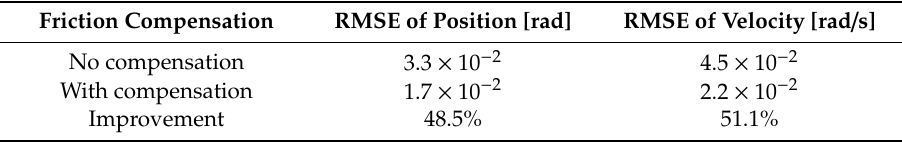
Table 2. Position and velocity tracking errors for joint